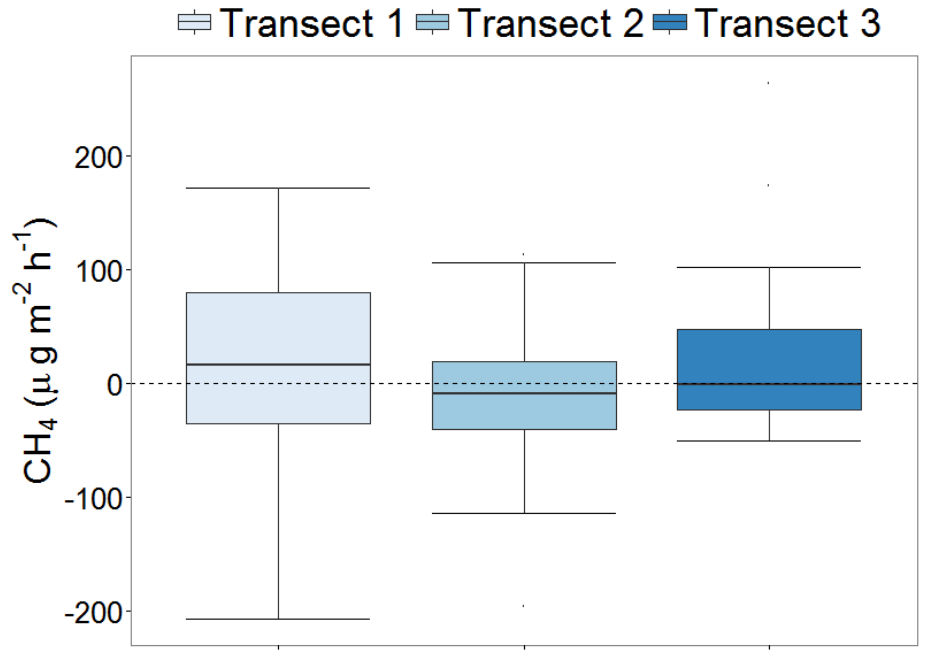
Figure 7. Methane emissions from plots along the slope catena of three transects based on combined data from all campaigns.